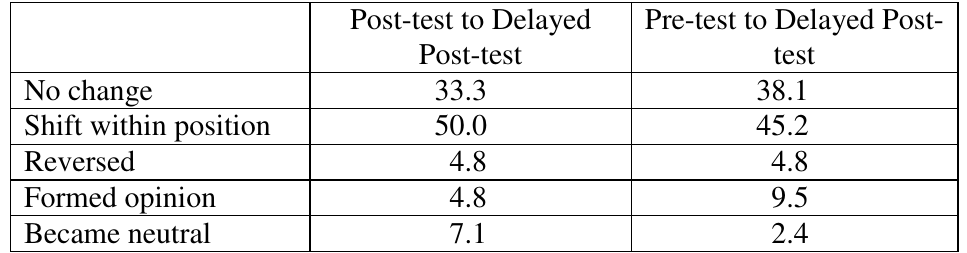
Table 7. Percentage of Participants Exhibiting Changes in Ratings of Hydropower